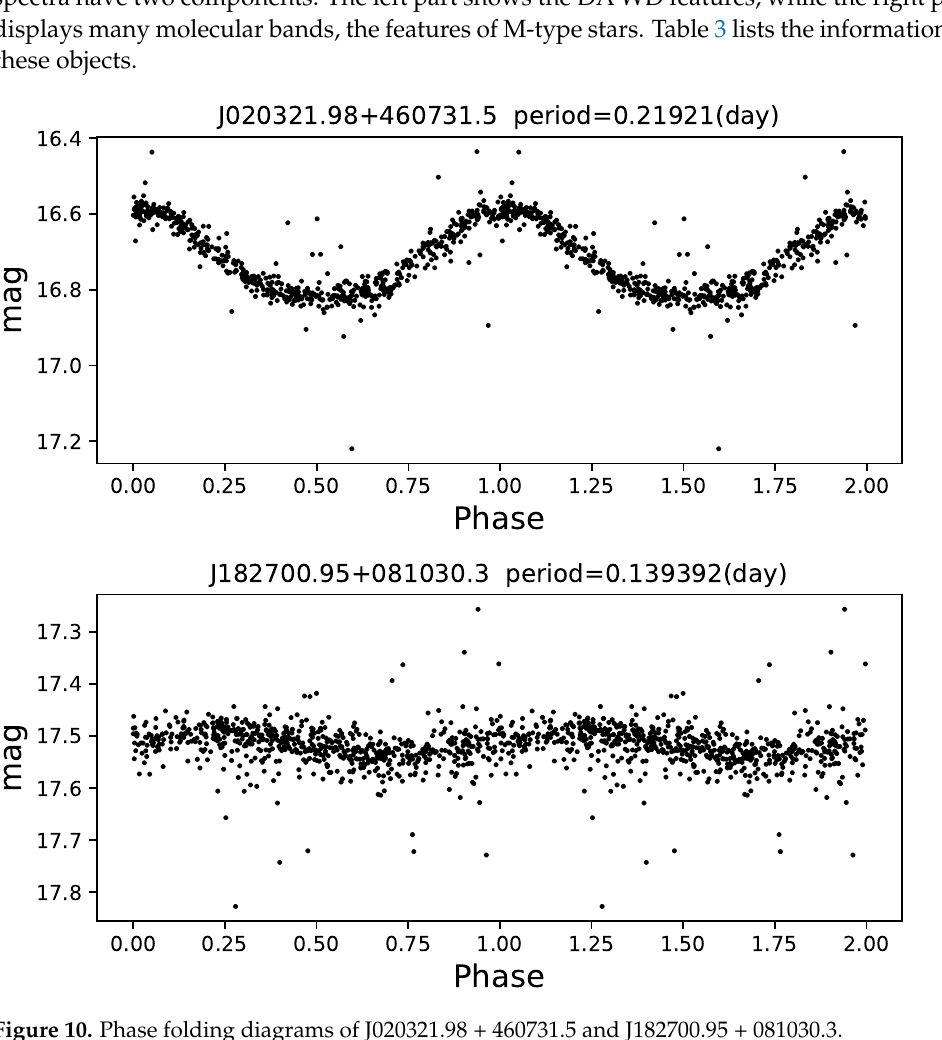
Figure 10. Phase folding diagrams of J020321.98 + 460731.5 and J182700.95 +